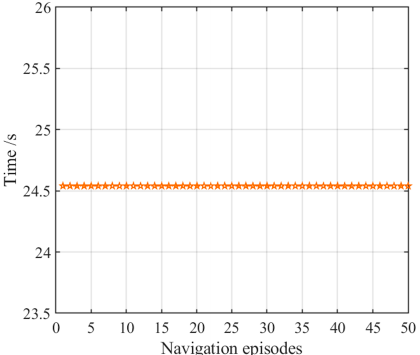
Figure 9. Navigation time with the hippocampal model alone. Orange pentagrams indicate the nav-